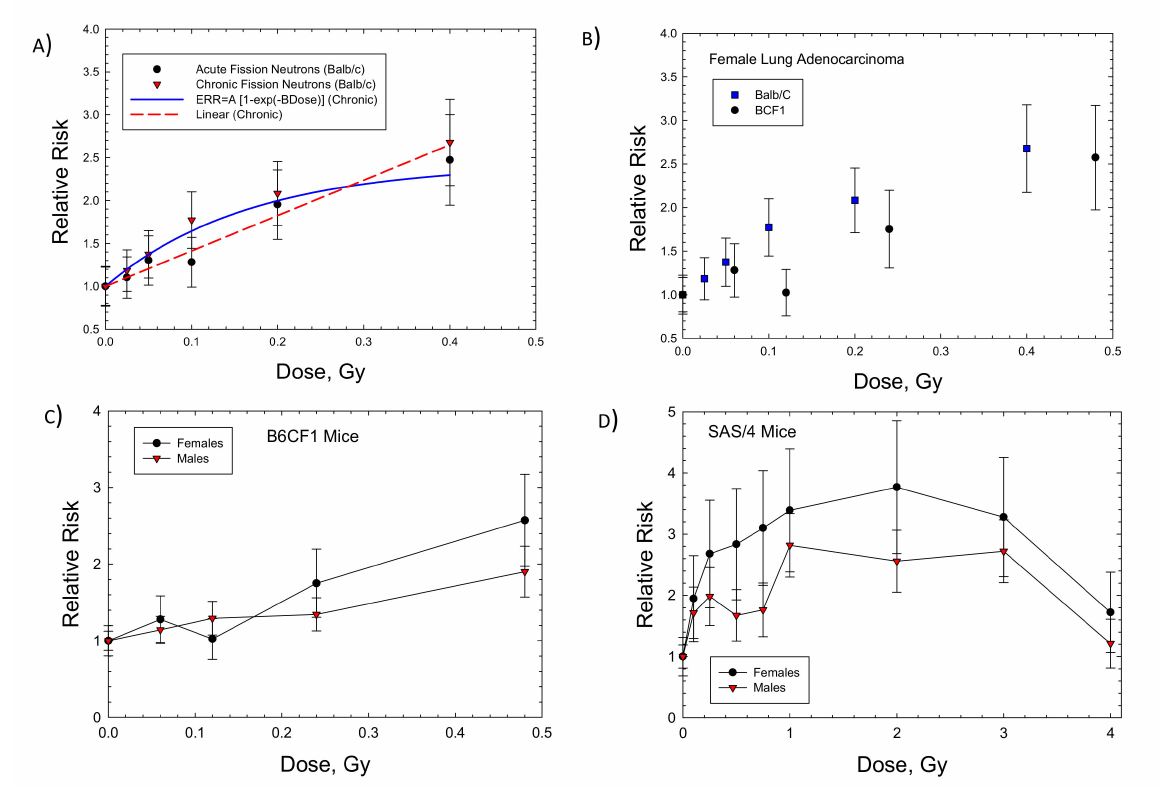
Figure 2. Dose responses for relative risk of lung adenocarcinomas in female Balb/c, B6CF1, or SAS/4 mice exposed to neutrons. ( A ) Female Balb/c mice exposed to fission neutrons (FN) showing linear and saturable ERR models [6]. ( B ) Comparison of Balb/c to B6CF1 mice exposed to FN. ( C ) Comparison of female to male B6CF1 mice exposed to FN. ( D ) Comparison of female to male SAS/4 mice exposed (thorax only) to cyclotron neutrons [16].